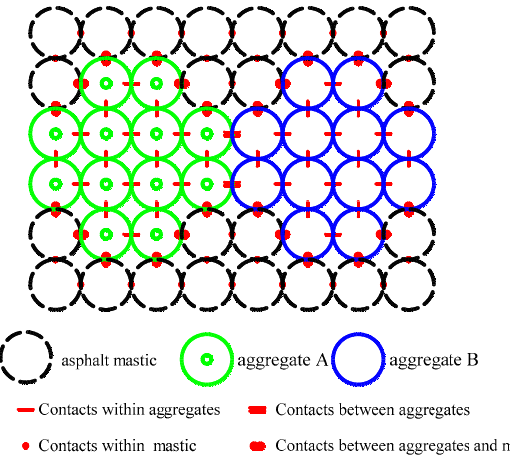
Figure 6. Interactions among the components within the asphalt mixture.